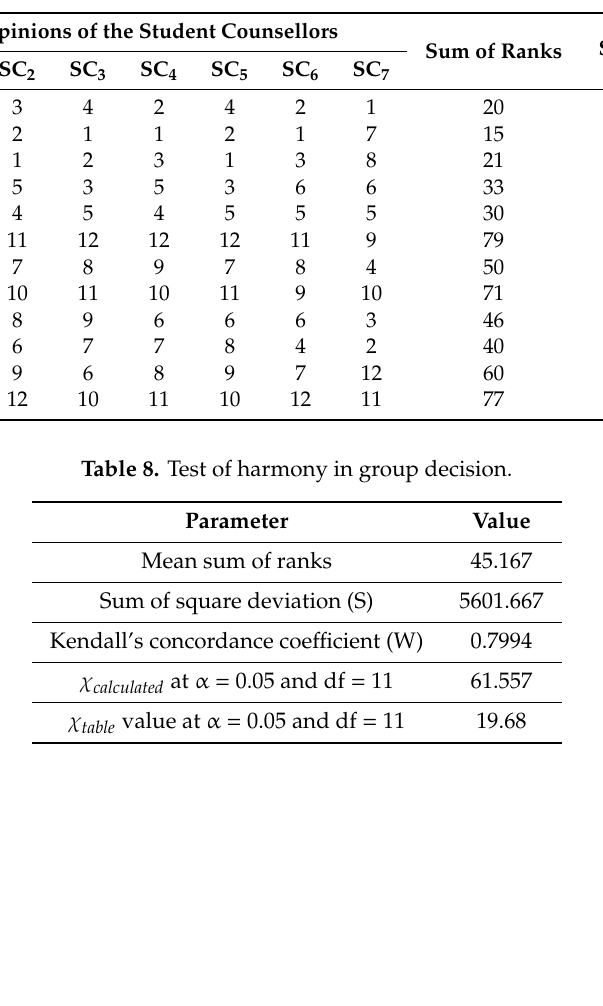
Table 7. Summary of responses of student counsellors (SCs) (priority-based ordering).